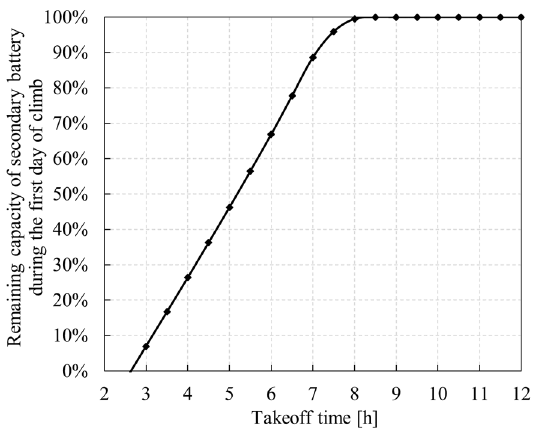
Figure 22. Variation of remaining capacity of secondary battery with takeoff time during the first day of climb.